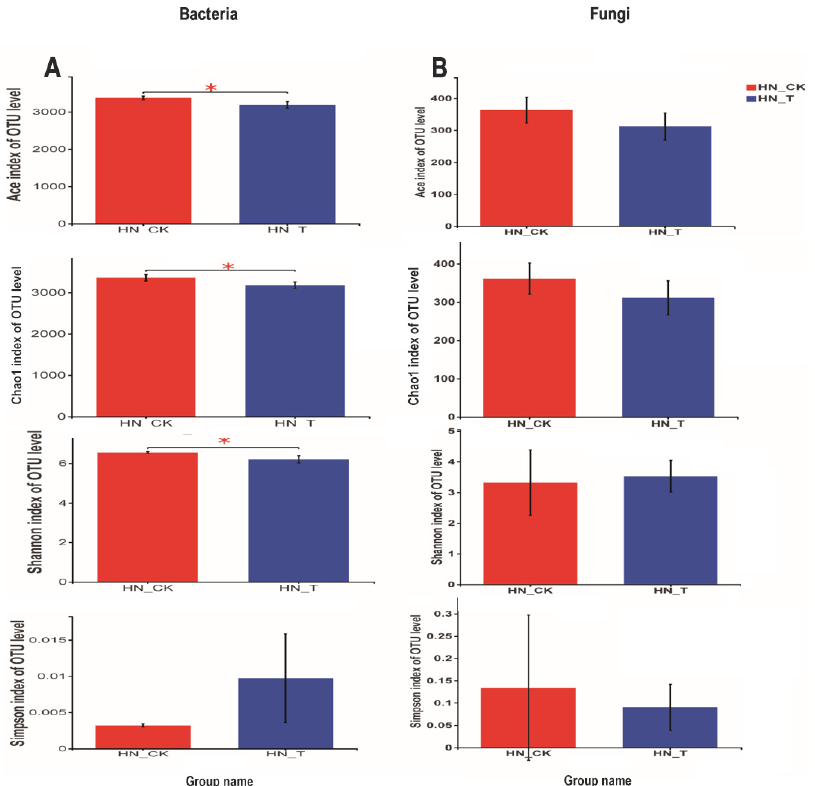
Figure 5. Chao1, ACE, Shannon and Simpson indices showing taxonomic changes in ( A ) bacteria and ( B ) fungi in triple-fumigated soil that had been used to produce ginger. ‘Triple fumigation’ refers to the simultaneous application of chloropicrin, dimethyl disulfide and metham sodium. The t -test reported the statistical differences (asterisked, * 0.01 < p ≤ 0.05) between the means of three replicates within each graph.